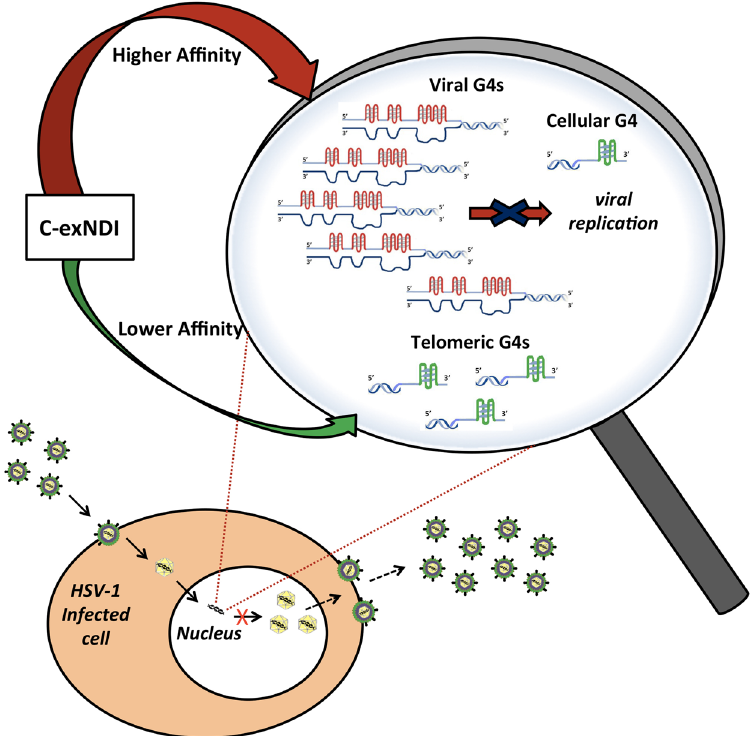
Figure 5. Scheme of the proposed c-exNDI mechanism of anti-HSV-1